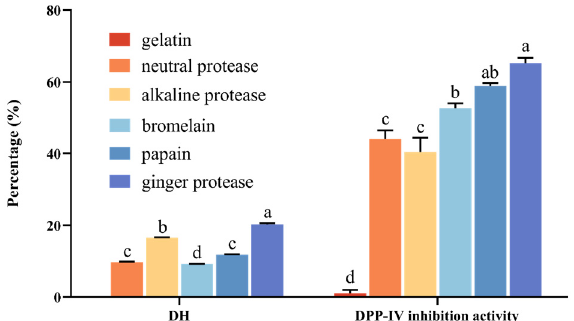
Figure 1. DH and DPP-IV inhibition activity of hydrolysates hydrolyzed using different enzymes. Different letters on bar graphs indicate significant differences ( p < 0.01).